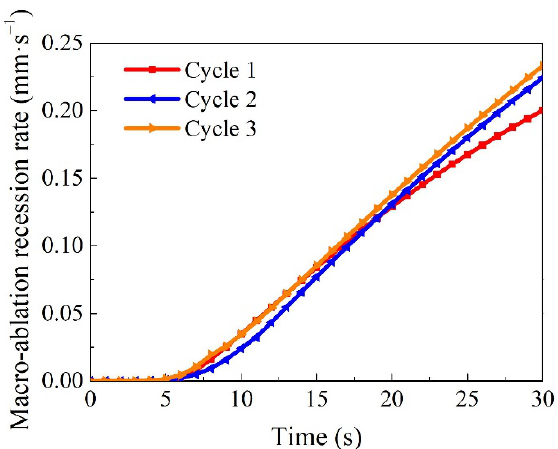
Figure 9. Variation of macro-ablation recession rate with ablation time at different cycle times.